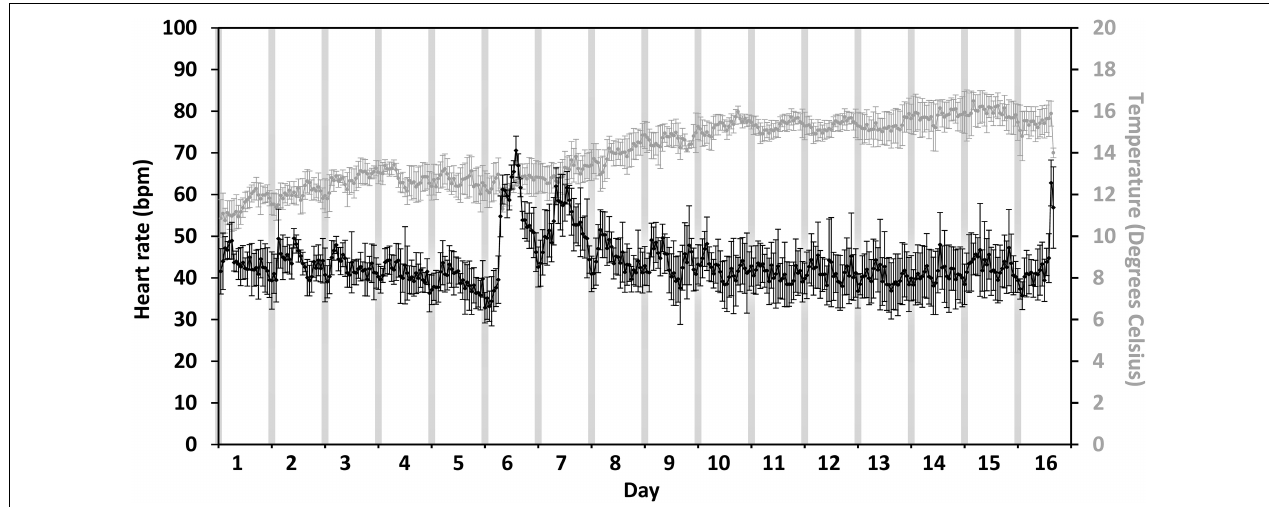
FIGURE 6 | Average fish response to a level 3 crowding event. Average hourly heart rate (black line) in bpm and temperature experienced (gray line) of six salmon collected at harvest. Heart rate and temperature are shown from the 5 days prior to final cage sampling (days 1–5, the 17th to the 21st of June), intense fish sampling (level 3 crowding event) from the cage (day 6, the 22nd of June) and post sampling till harvest (days 7–16, the 23rd of June to the 2nd of July). Error bars represent ± 95% CI. Gray bars indicate approximate civil hours of